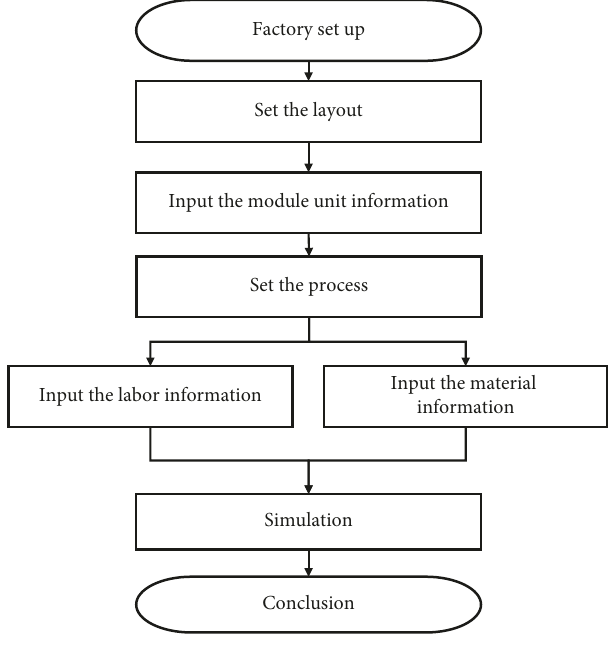
Figure 4: Software